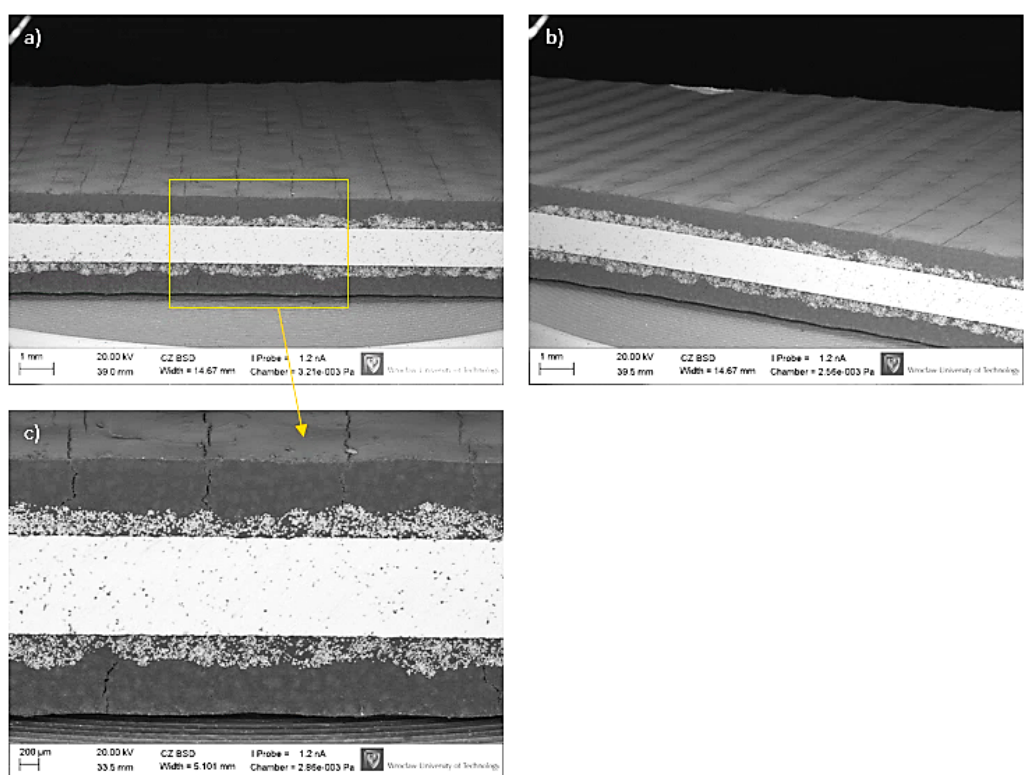
Figure 6. SEM images of the variant 3 (S3) sample fractured during three-point bending tests in perpendicular to the main axis direction (( a – c ) see description in the text).